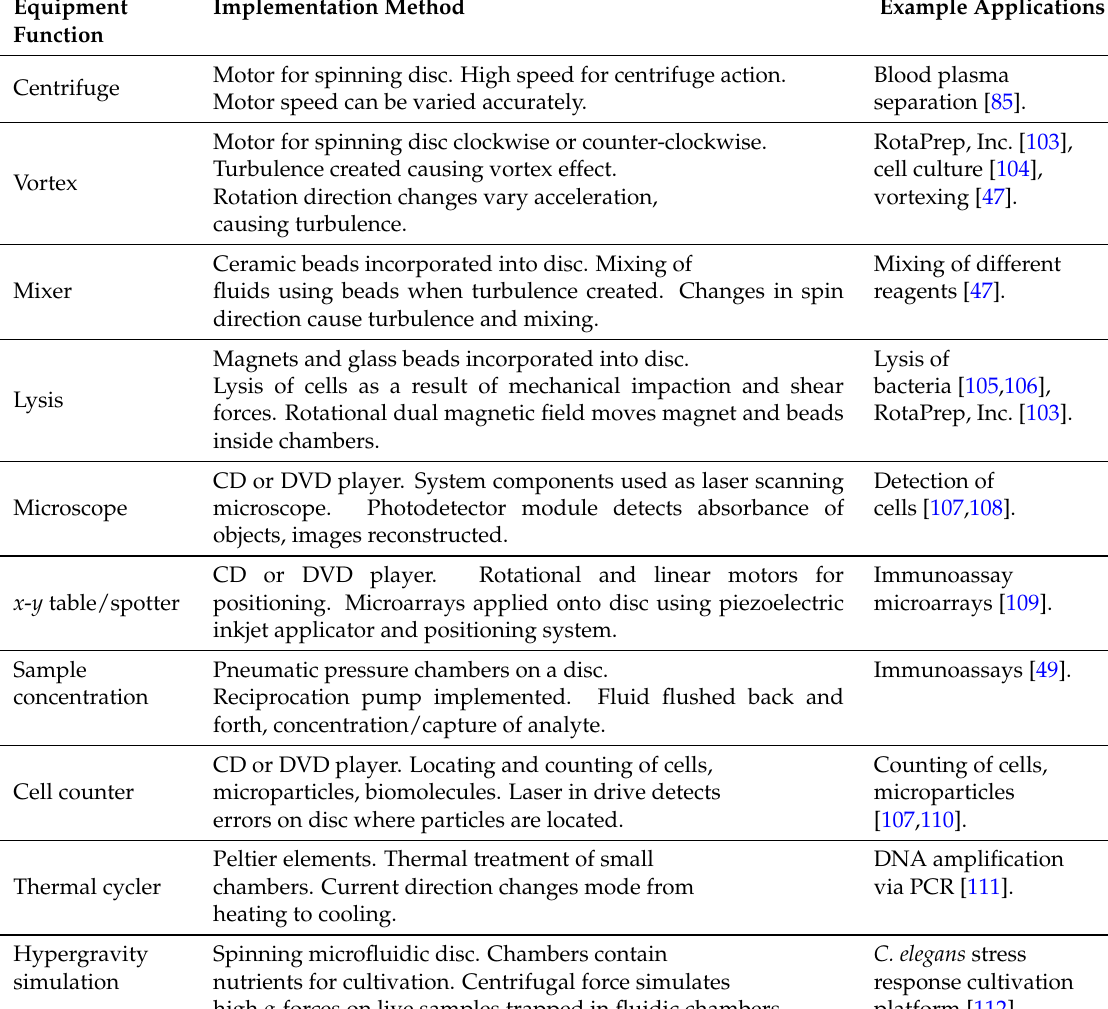
Table 1. The utility of a CD player as a diagnostic instrument with example applications.